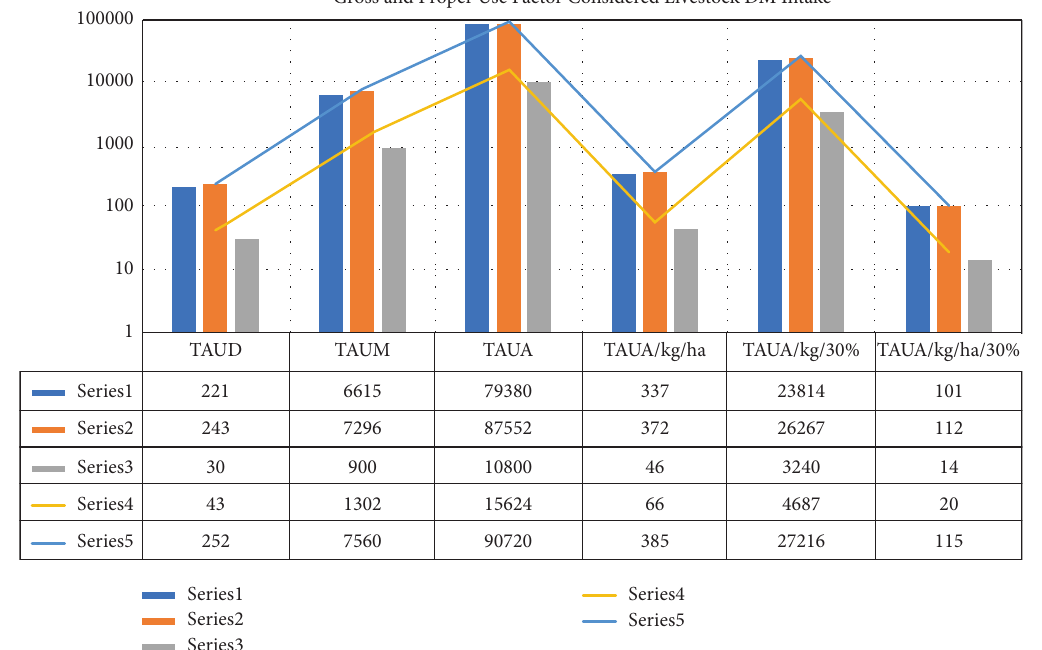
Figure 8: Total livestock gross and proper use factor considered DM intake from the Surra mountain government plantation (source: adapted from diferent types of